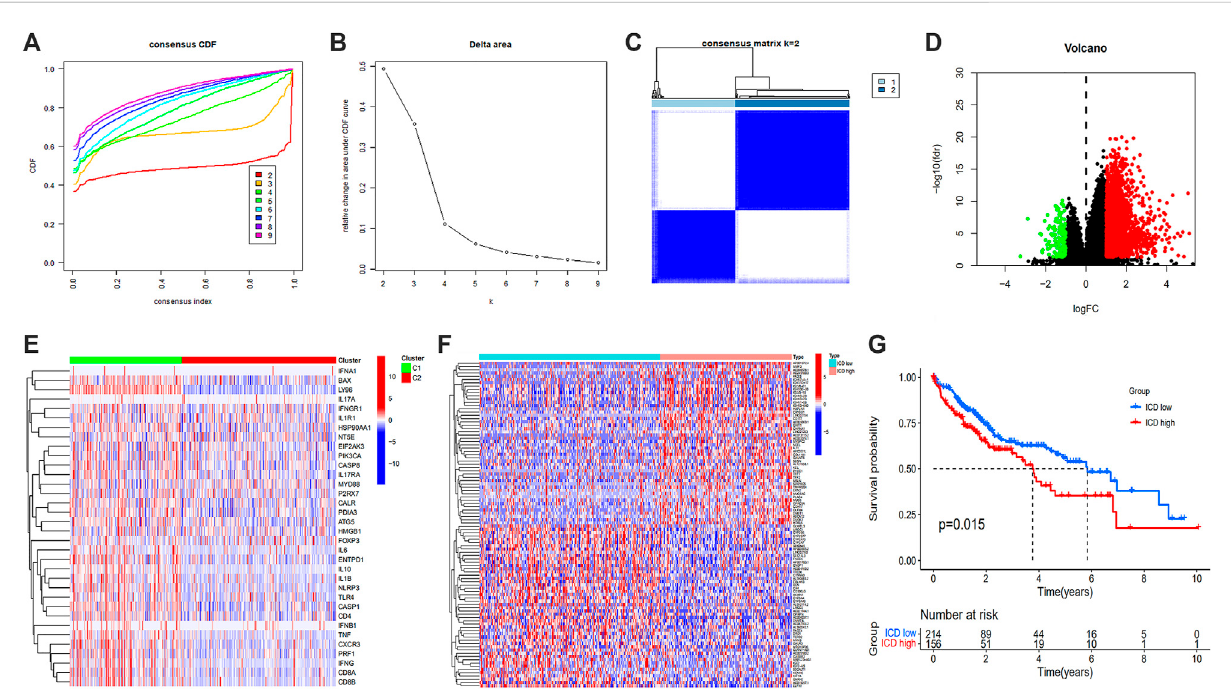
FIGURE 4 UnsupervisedconsensusclusteringofHCCsamplesbasedonICDassociatedDEGs (A,B) ,consensusCDFcurveandareaunderCDFcurvewhenk= 2 – 9 (C) ,twoclustersaccordingtothebestconsensusmatrix(k=2) (E) ,volcanoplot (D) ,heatmap (F) ,andKaplan-Meiersurvivalplot (G) ofDEGsbetween ICD high and low expression groups. (HCC: Hepatocellular carcinoma, ICD: Immunogenic cell death, DEGs: Differentially expressed